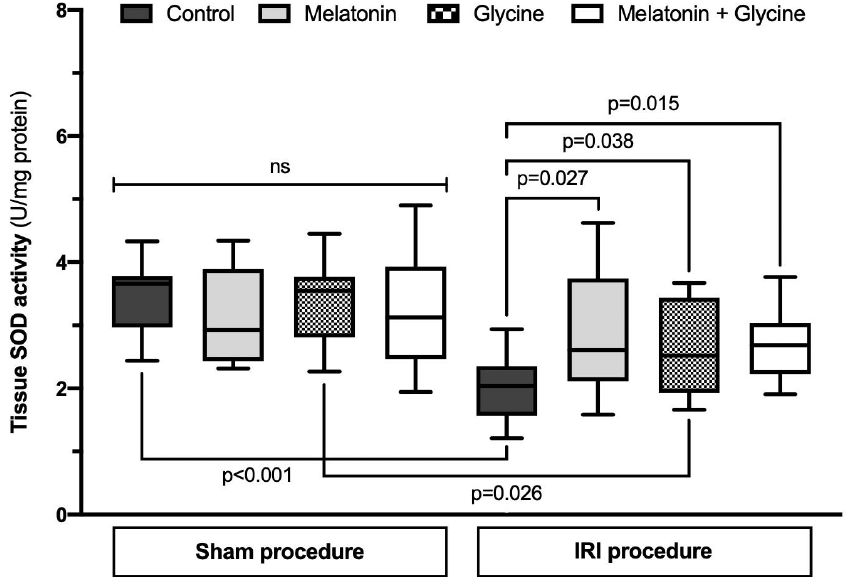
Figure 4. Superoxide dismutase activity in uterus tissue. IRI: ischemia/reperfusion injury. SOD: superoxide dismutase. Data presented as median and interquartile range ( n = 10/group, except n = 9 in sham combined treatment group).